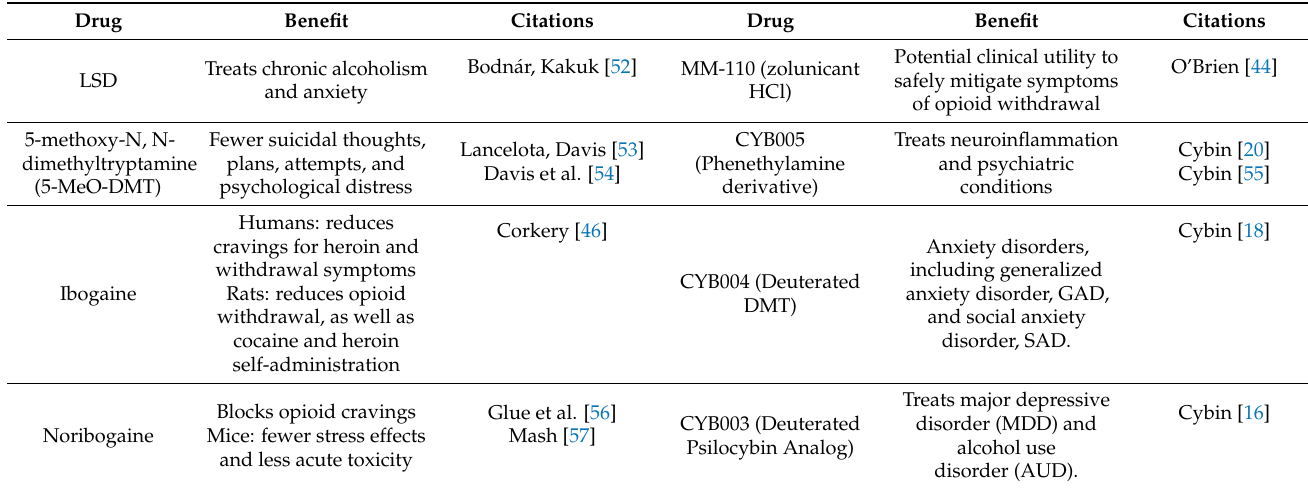
Table 2. Highlights of the psychoceutical